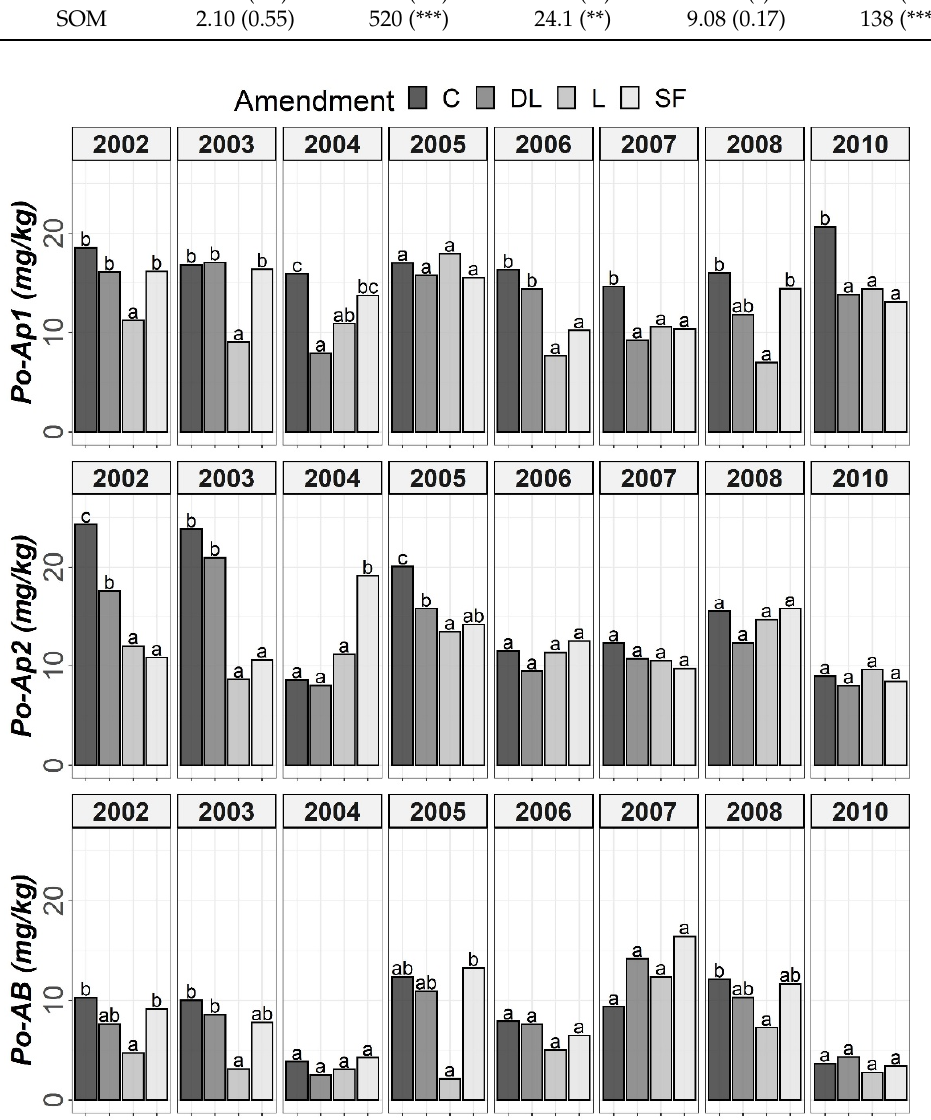
Figure 1. Temporal evolution of Olsen’s phosphorus (Po) in the three horizons (Ap1, Ap2 and AB) studied throughout the soil monitoring period (2002–2010). Bars within each year and horizon followed by different lowercase letters reflect significantly different averages according to Tukey’s honest significance test with Holm–Bonferroni adjustment ( p = 0.05).